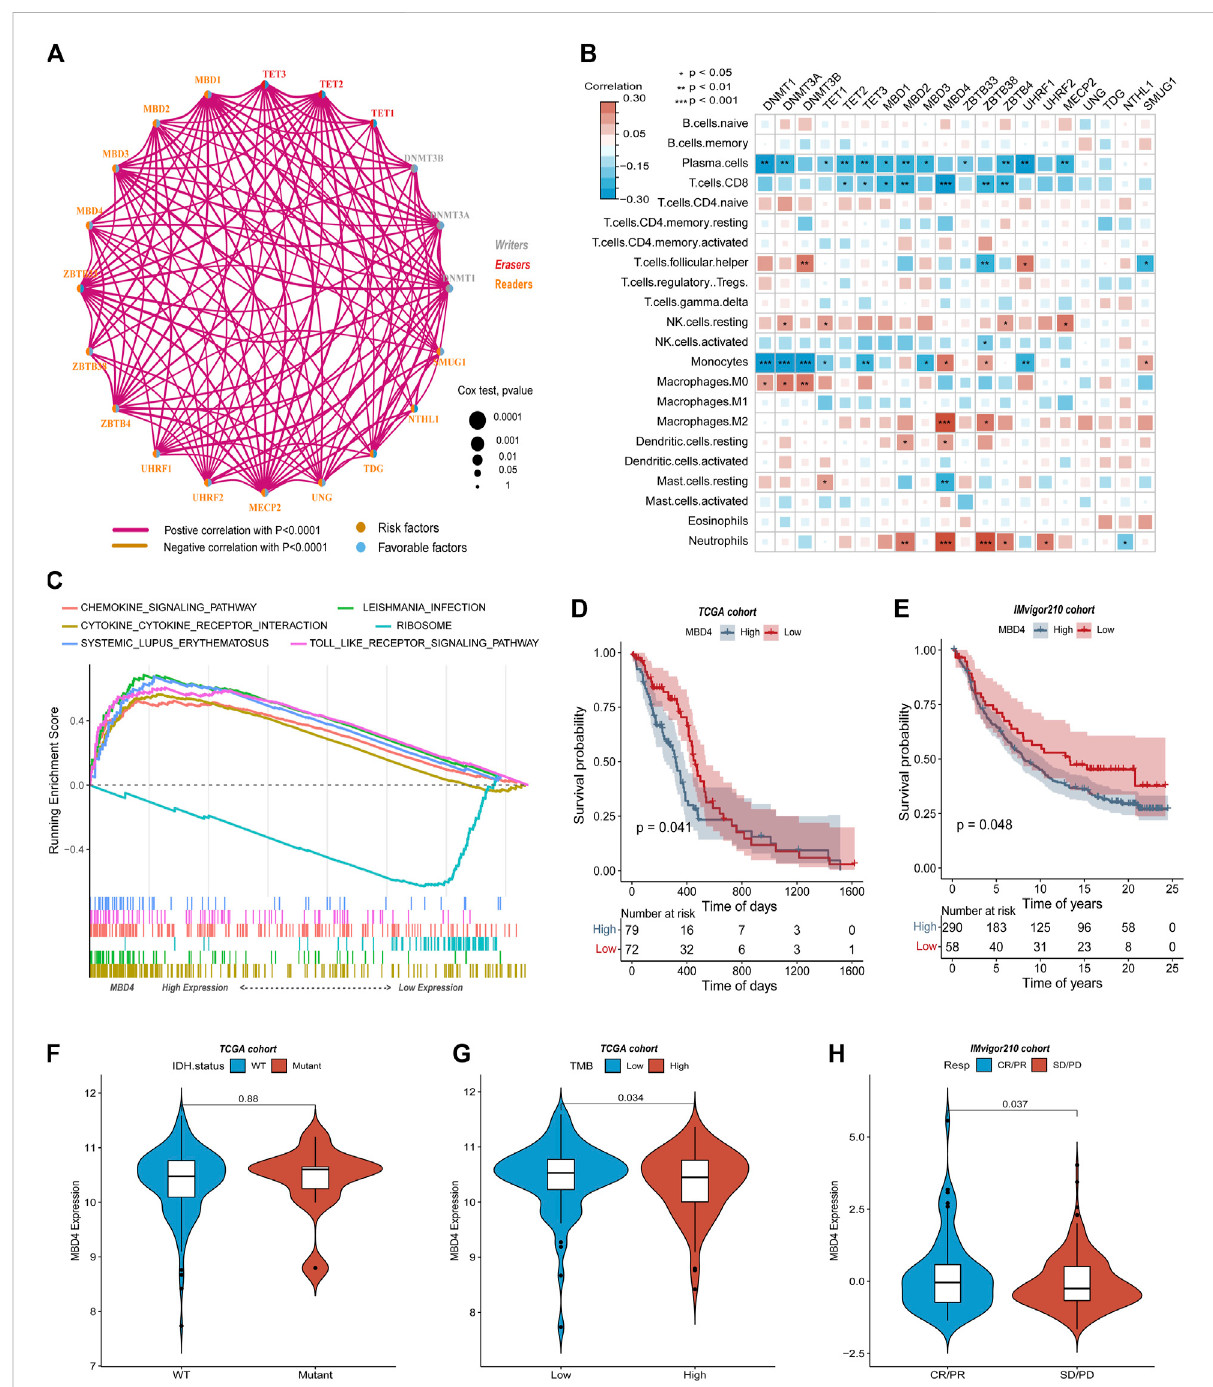
FIGURE 3 TCGA-GBM data on immune cell in fi ltration and DNA5mC regulators. (A) Coexpression network of DNA5mC regulators. (B) Heatmap of gene correlation with immune cell in fi ltration. (C) GSEA for high and low gene expression. (D – E) Survival analysis of the TCGA-GBM and IMvigor cohorts. (F – G) Comparison of gene expression in TCGA-GBM and IMvigor cohorts. (H) Gene expression differences between immunotherapy responders and